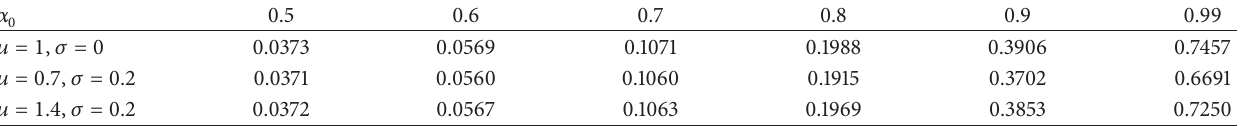
Table 2: The upper bounds of the delay (sampling period) for different values of 𝛼 0 and the conditions of actuator.